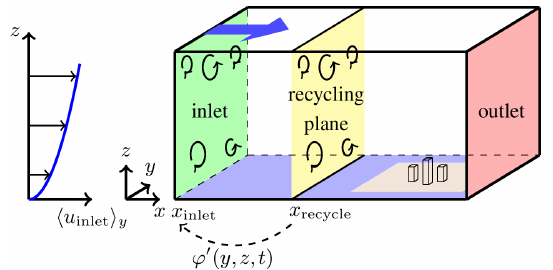
Figure 3. Schematic figure of the turbulence recycling method used for generation of turbulent inflow. The configuration represents ex- emplary conditions with a built-up analysis area (brown surface) and an open water recycling area (blue surface). The blue arrow indicates the flow